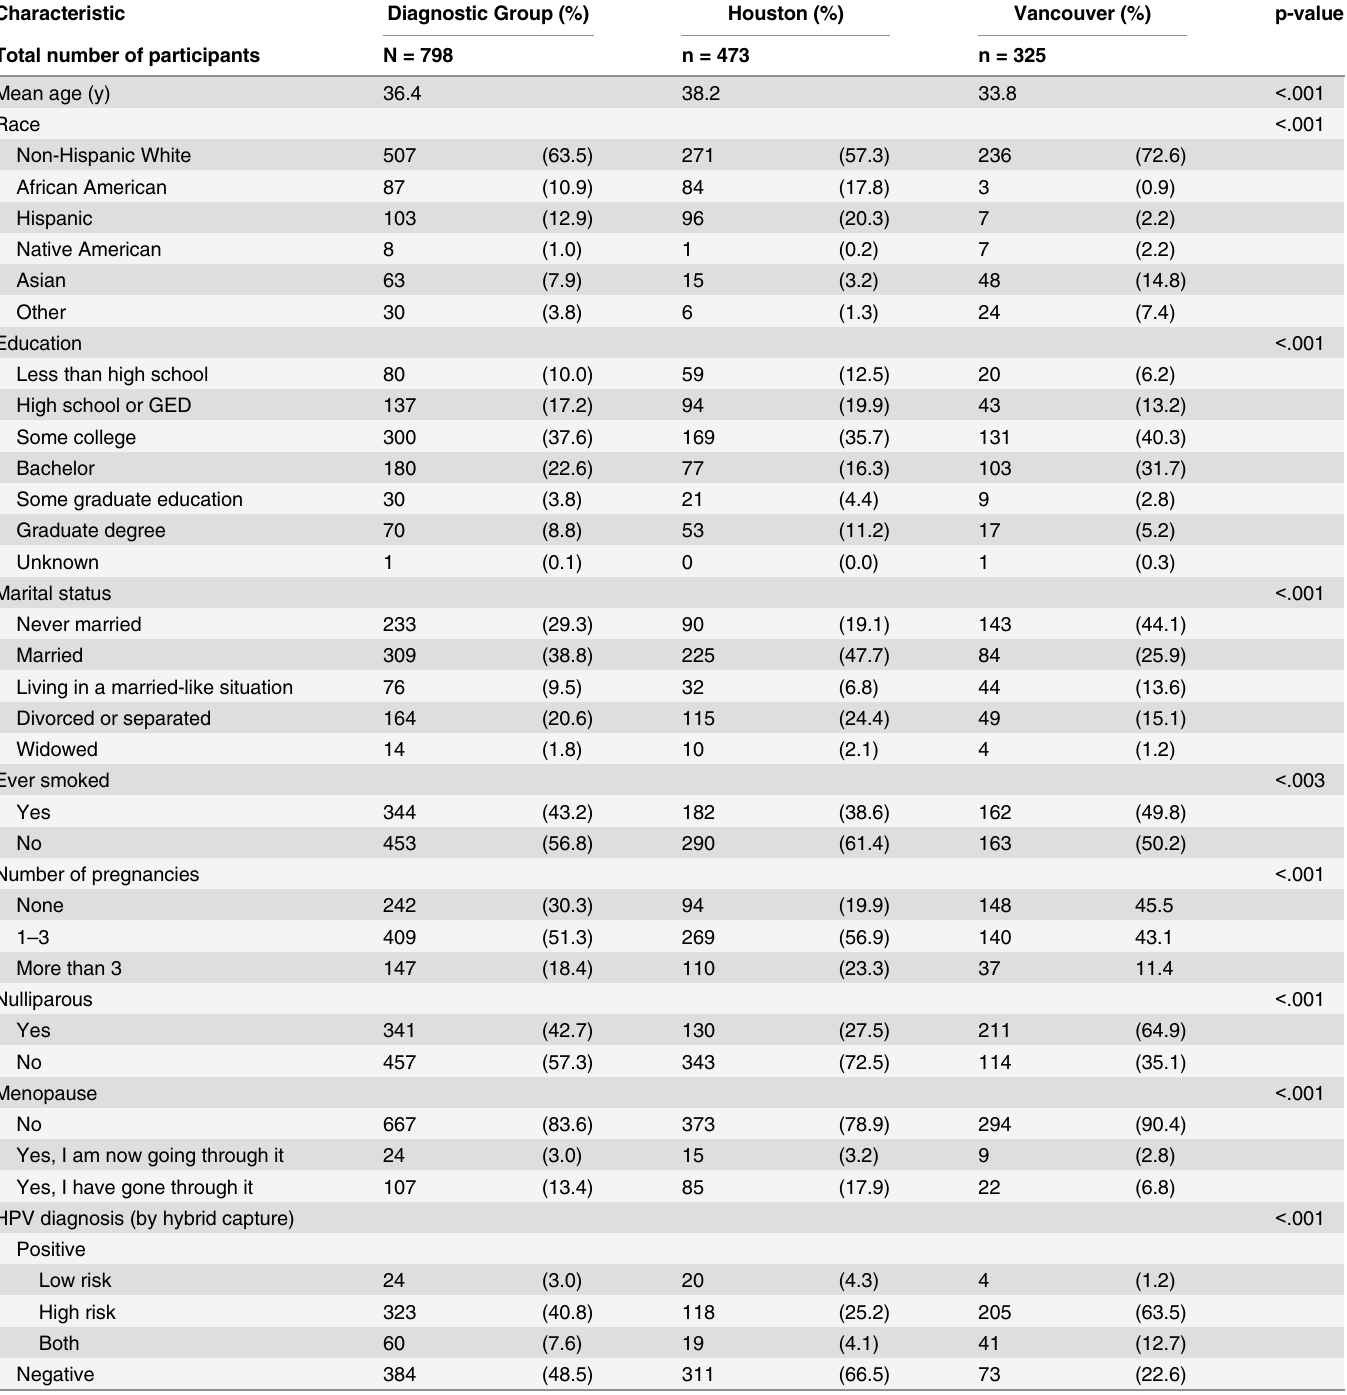
Table 1. Demographic and Clinical Characteristics of Diagnostic Group